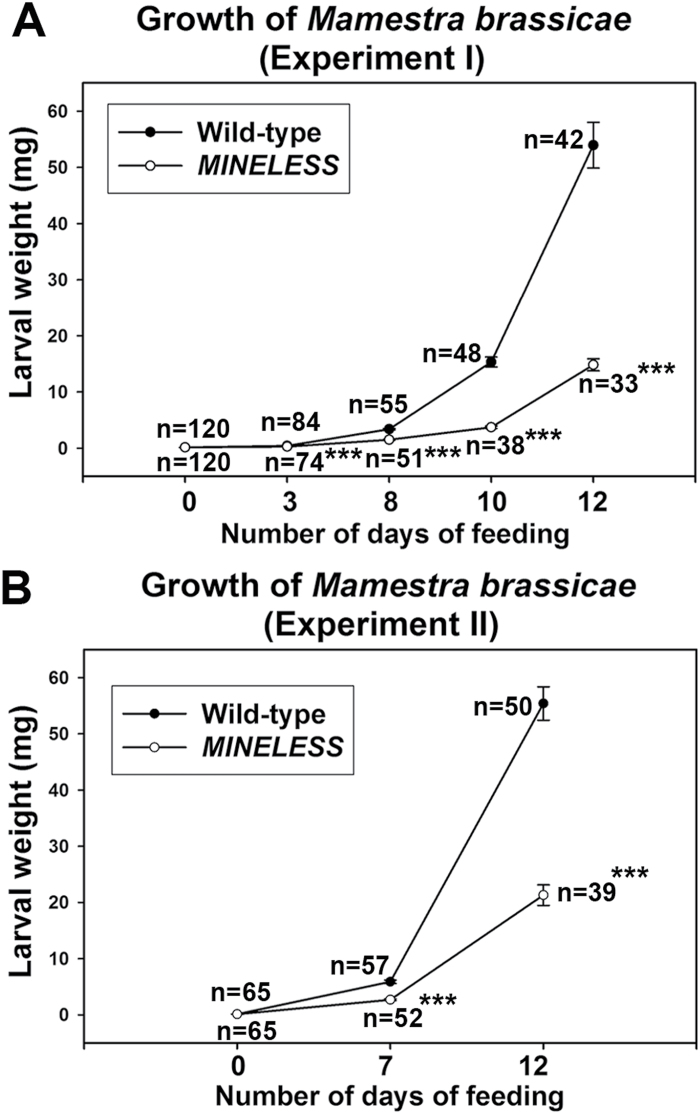
Growth of M. brassicae on wild-type and MINELESS plants in no-choice feeding experiments. (A, B) The weights of larvae feeding on wild-type and MINELESS seedlings differed significantly for day 3, 8, 10, and 12 (A); and day 7 and 12 (B). n, number of larvae. Values represent mean ± SE; ***, P < 0.001 (Wilcoxon Mann-Whitney test).